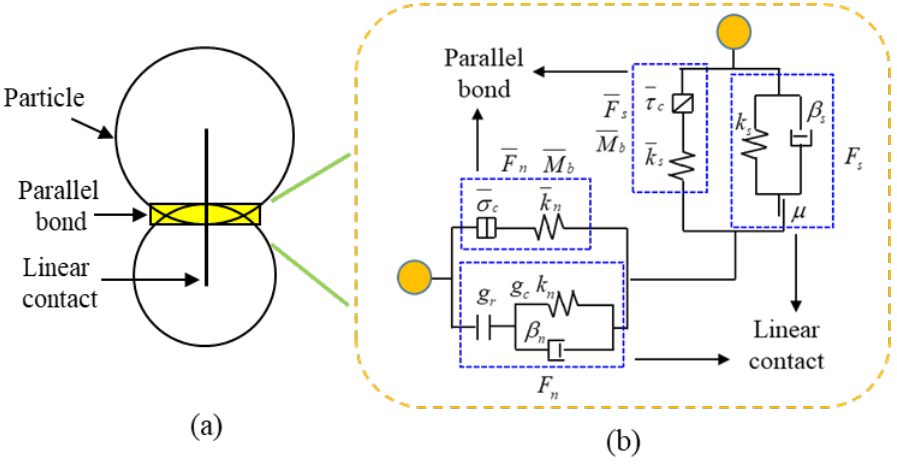
Figure 2. Schematic of parallel bond model: ( a ) composition; ( b ) mechanical behavior.